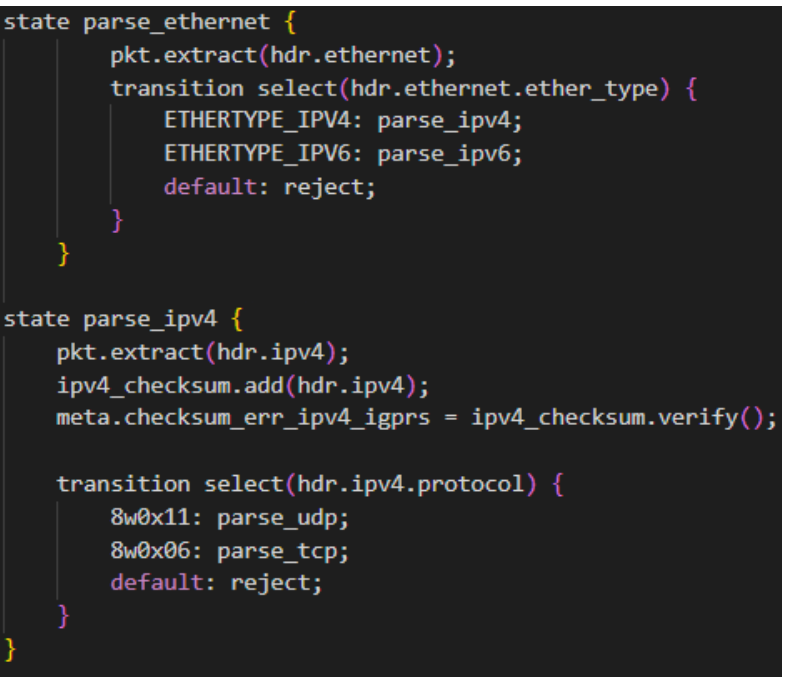
Figure A2. Example P4 Parser